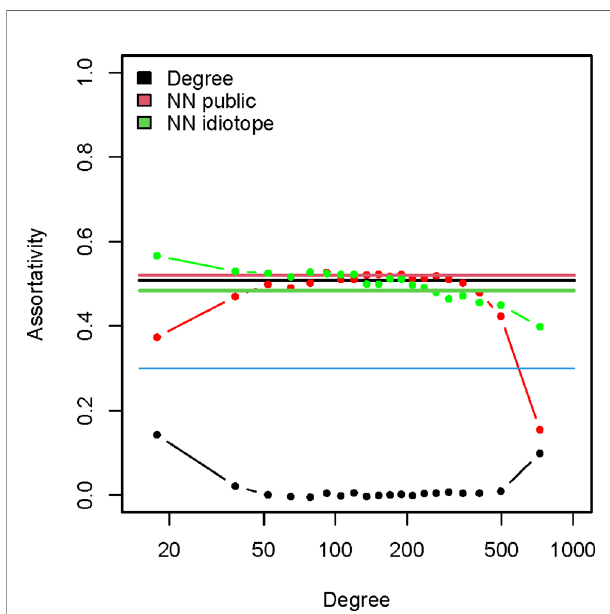
FIGURE 8 | Assortativity of the igome graph. The straight lines indicate the overall assortativity for the graph for the degree (black), number of public mimotope neighbors (red) and number of putative idiotope neighbors (green). The dotted lines represent the respective assortativity values for induced subgraphs strati fi ed by degree. The vertices were sorted in 20 bins by degree and these groups were used to generate induced subgraphs. The mean degree of each group is on the X